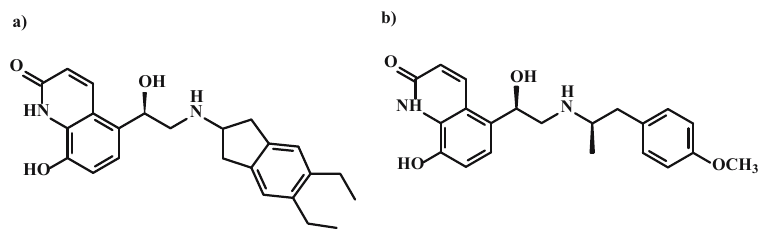
Figure 12: Chemical structure of ( a ) indacaterol and ( b ) carmoterol.